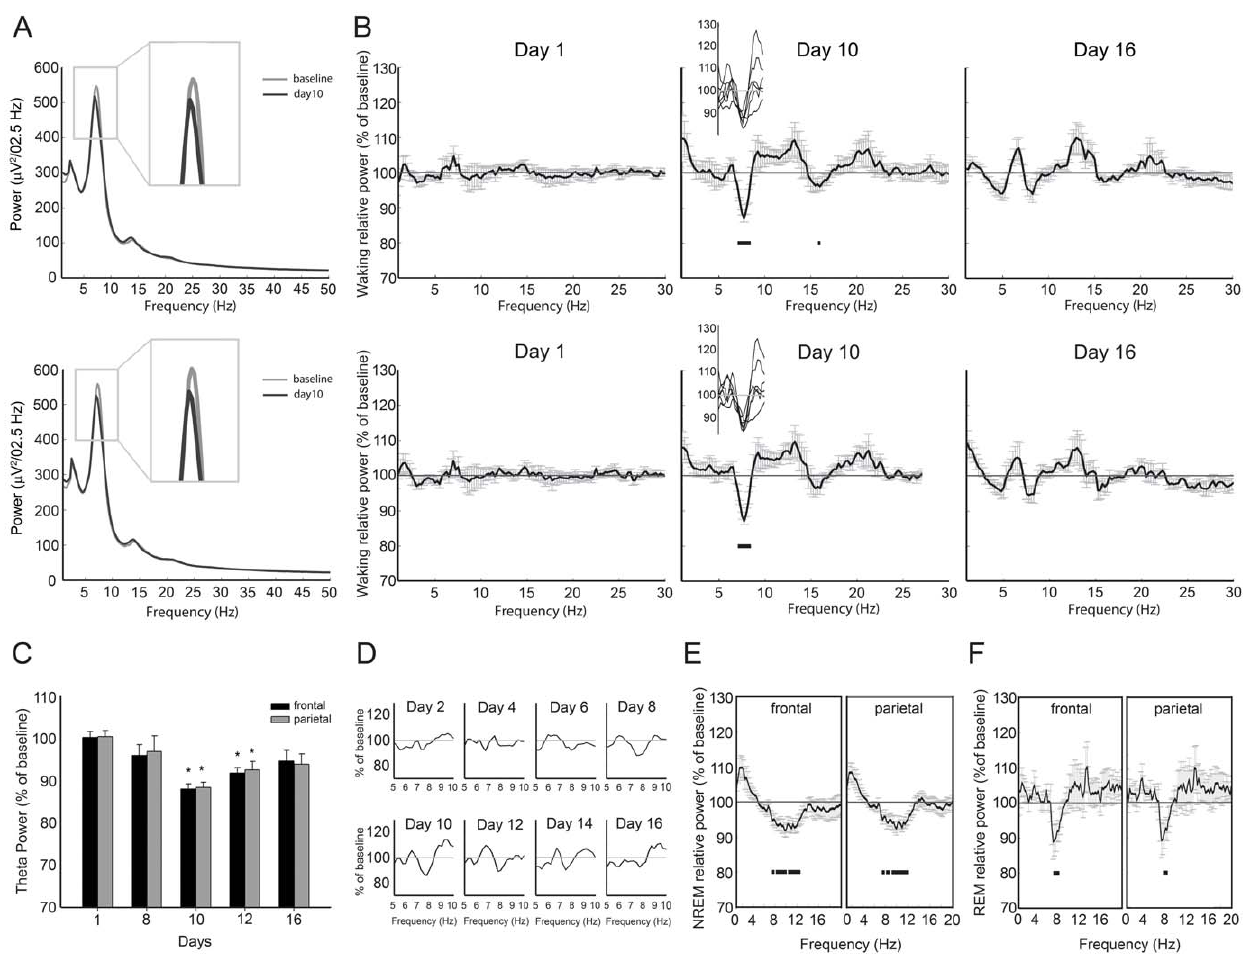
Figure 2. Power spectra analysis following ceftriaxone administration. A. Reduction in theta power at day 10. Waking mean absolute power spectra of Day 0 and Day 10 for frontal (above) and parietal (below) EEG channel. B. Power spectra analysis relative to the baseline illustrating a reduction of theta power at Day 10 (shown in detail for single animals in the small inset) and a return to the baseline eight days after CEF withdrawal (Day 16) in frontal (above) and parietal (below) EEG channels. Statistical significance (p , 0.05) is represented by black dots. Values are mean 6 sem. C. Time course analysis of relative spectra (7–9 Hz frequency band) showing a significant reduction of theta power for frontal and parietal channels two days (Day 10) and four days (Day 12) after CEF withdrawal compared to the baseline (Day 0). *p , 0.05. Values are mean 6 sem. D. Example of power spectrum relative to the baseline for a representative animal during the entire length of the experiment. E. Frontal and parietal relative spectra showing a broad band (7–13 Hz) reduction in power during NREM sleep at day 10. Statistical significance (p , 0.05) is represented by black dots. Values are mean 6 sem. F. Frontal and parietal relative spectra showing a reduction in theta power during REM sleep at day 10. Statistical significance (p , 0.05) is represented by black dots. Values are mean 6 sem.